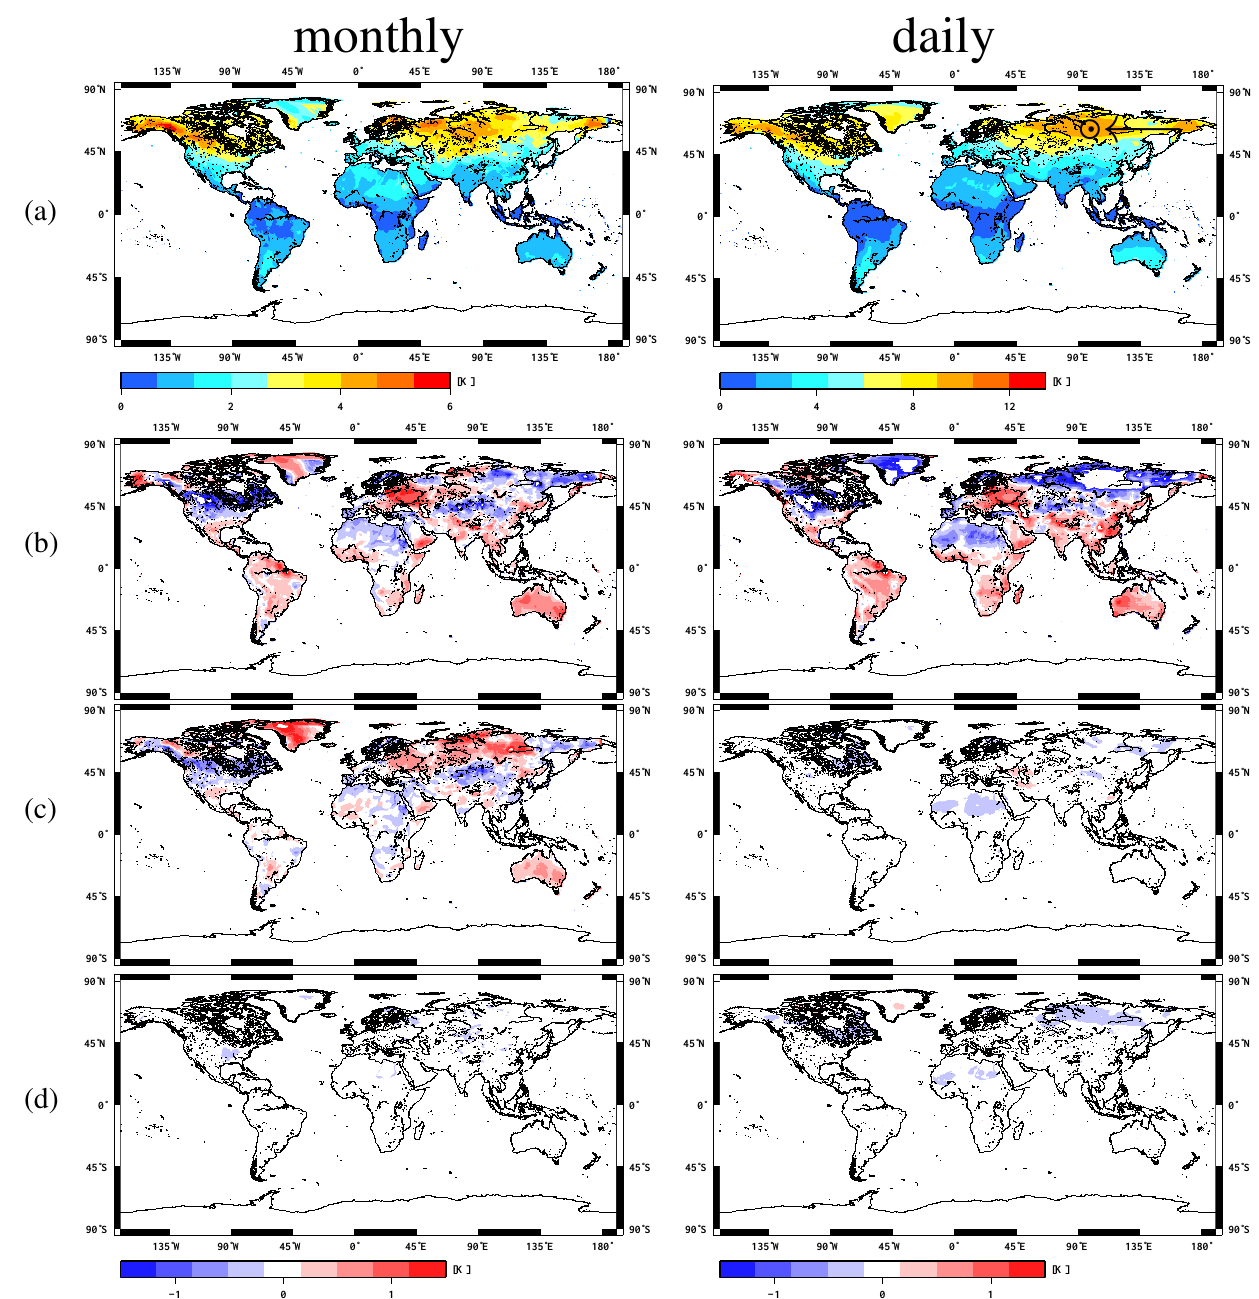
Fig. 4. Comparison of December standard deviation of monthly mean temperature (left) and standard deviation of daily temperature (right) for observations (a) and the ECHAM5/MPI-OM model: (b) , difference plot of standard deviation of the original ECHAM5 minus standard deviation of observations; (c) , same as (b) but using bias corrected data; (d) , same as (b) but using cascade bias correction. Note the change in scale between monthly and daily data in (a) . Circle and arrow in (a) , right panel, mark a point used for time series in Fig. 5.